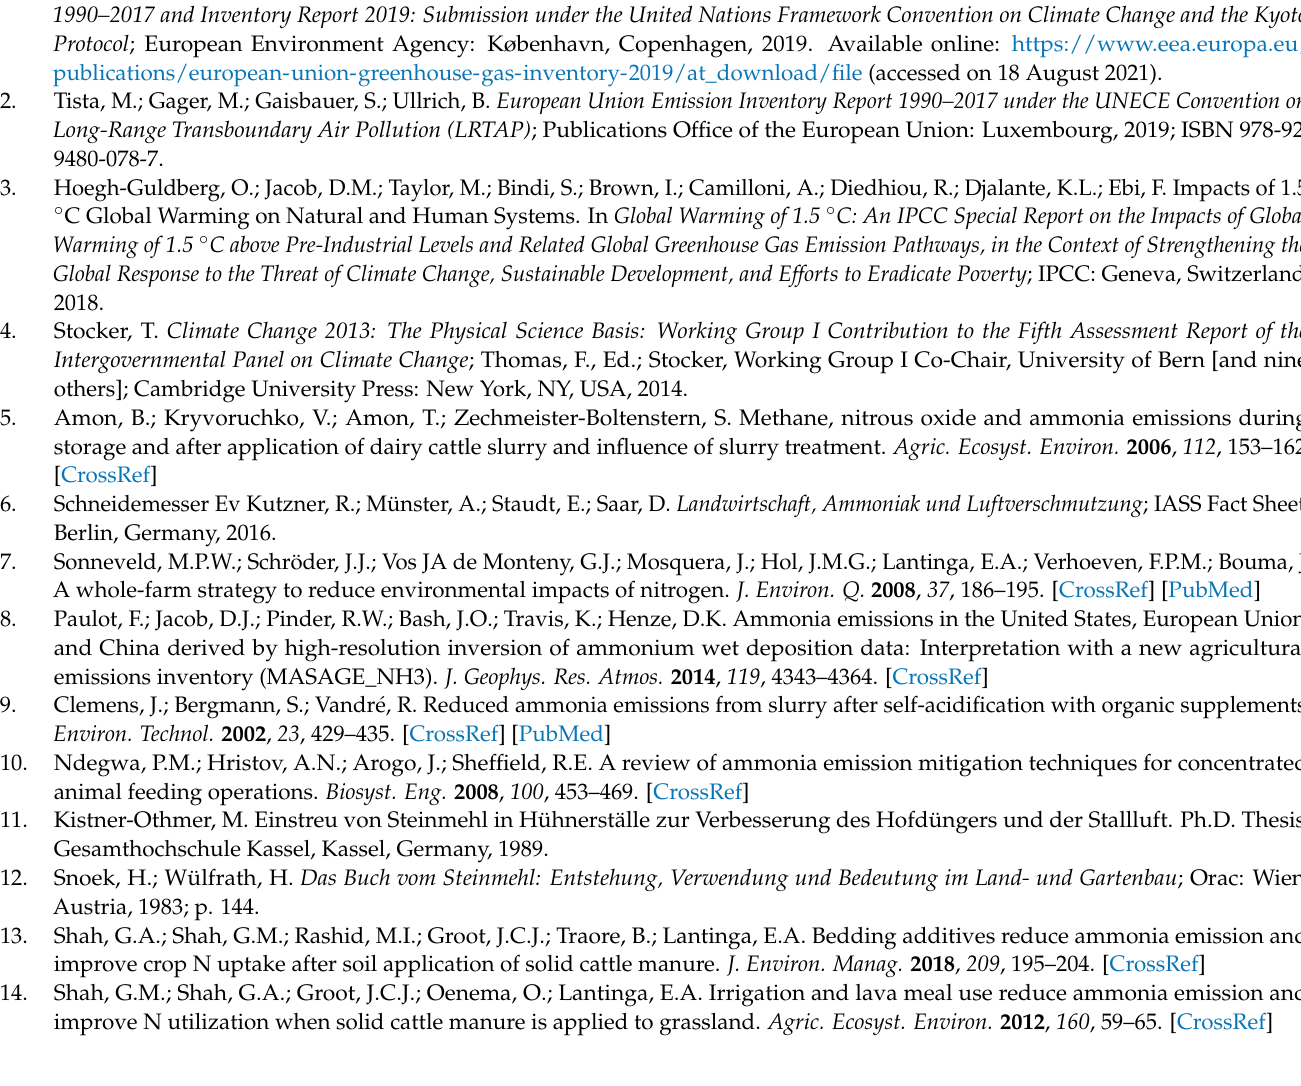
Figure A2. Eifelgold slurry at day 42, surface mostly liquid and no crust formation visible.